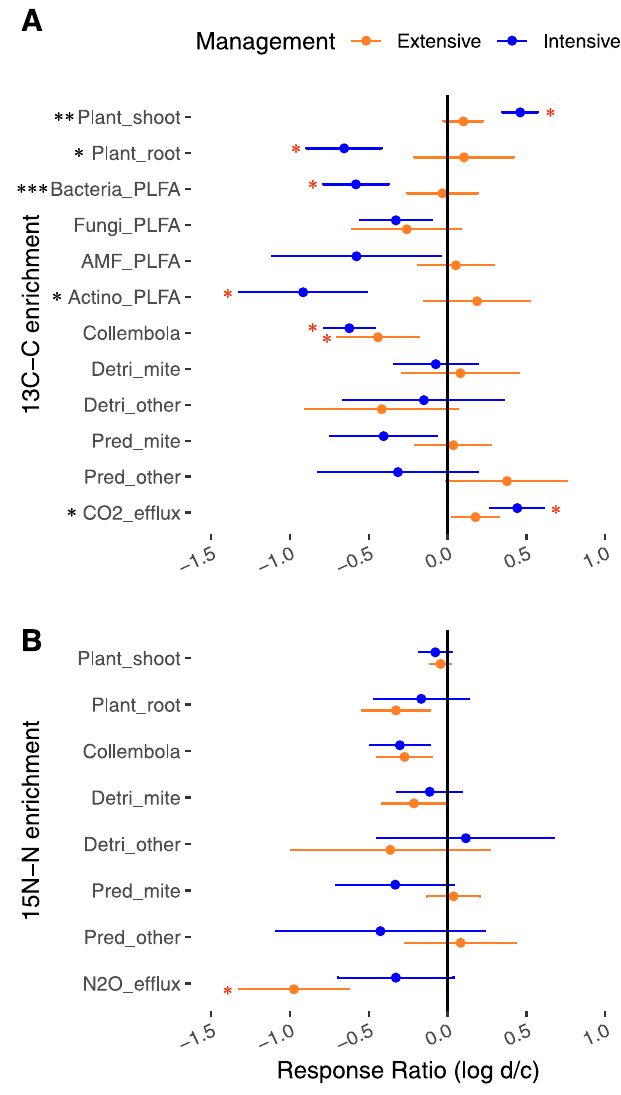
Fig. 2 | Management impact on the drought effect on tracer transfer in the plant-soil system. Response ratio of the post-drought effect on the 13 C (A) or 15 N (B) enrichment of the different pools as a function of grassland management (log (drought/control)). The sign (positive or negative) of the logRR corresponds to the direction of the drought effect on the 13 C or 15 N enrichment, while a response ratio of zero indicates no post-drought effect. This fi gure only highlights the strongest effects as logRR values have been calculated on averaged 13 C or 15 N enrichment across all sampling dates. Dots represent mean ± SEM ( n =18). Sig- ni fi cance for management effect on the logRR from two sided linear mixed- models are reported with *** P <0.01, ** P <0.01, * P <0.05. Red asterisks indicate signi fi cance for drought effect by the examination of the con fi dence intervals of predicted means from the linear mixed-effects models, see Supplementary Table 1 for details. amf_PLFA AM fungal PLFA, actino_PLFA actinobacteria PLFA, detri_mites decomposer mites, detri_other other decomposers, pred_mite pre- datory mites, pred_other other